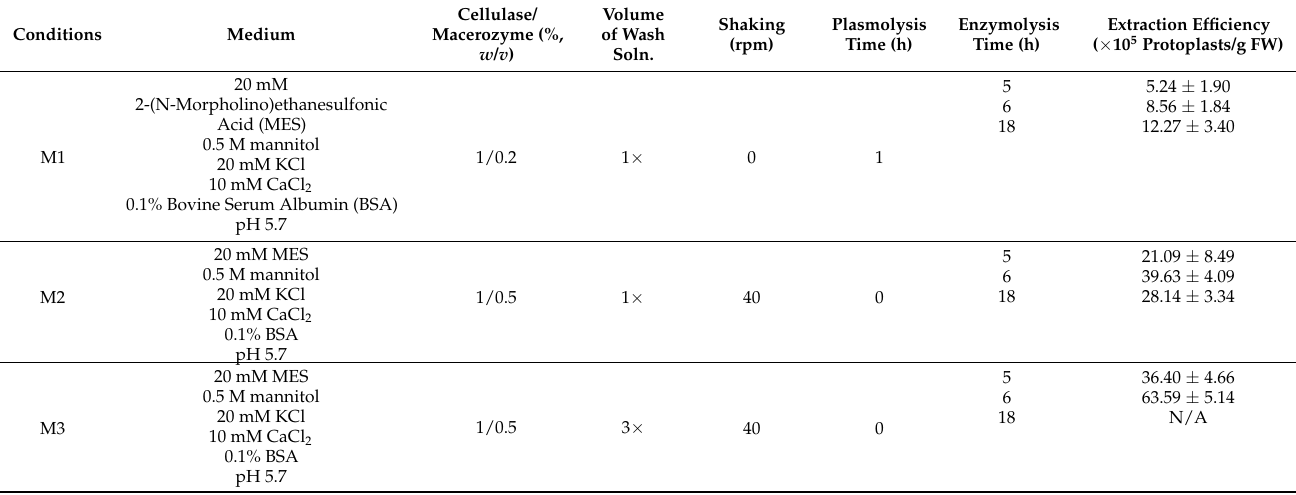
Table 3. Comparison of extraction efficiencies according to the combinations of various factors for protoplast extraction.